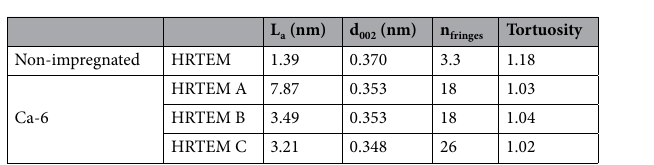
Figure 5. ( a ) HRTEM image of non-impregnated cellulose biochar (X500000). ( b ) HRTEM image of Ca-6 sample (X400000). ( c ) Processed image of non-impregnated cellulose biochar. ( d ) Processed image of Ca-6 sample image.